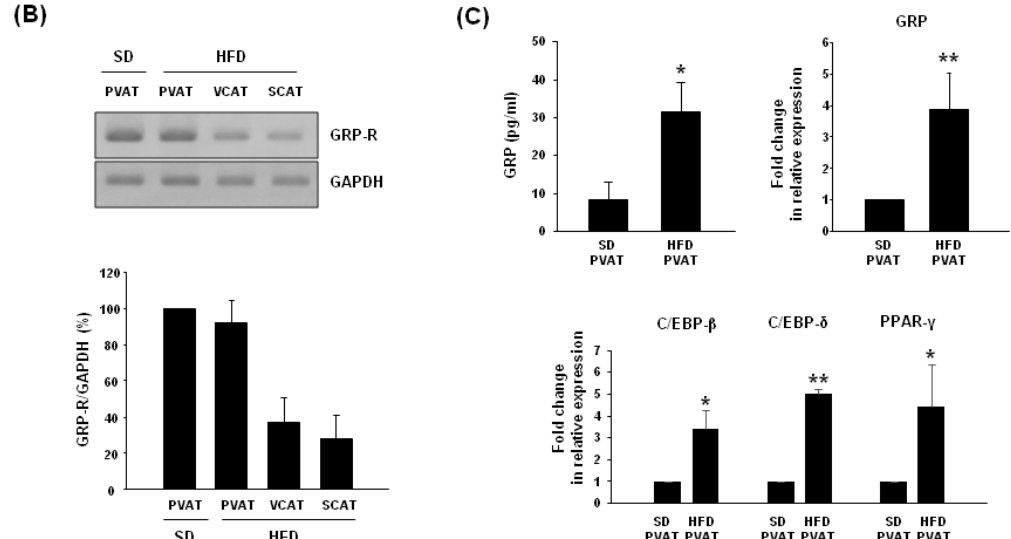
Figure 4. Expression of GRP-R and GRP in adipose tissues from obese rats. ( A ) The SD (standard diet) group was fed a standard diet, and the HFD (high-fat diet) group was fed a high-fat diet for 14 weeks. The body weight was measured once every two weeks. ( B ) All rats were sacrificed at week 14, and subcutaneous (SCAT), visceral (VCAT) or perivascular adipose tissues (PVAT) from the HFD group and perivascular adipose tissues from SD group were obtained. The total RNA was extracted from each adipose tissue and then analyzed by RT-PCR using primers specific for GRP-R. GAPDH served as an internal control (top). The graph shows the densitometric analysis of the relative GRP-R mRNA levels. The GRP-R expression from the PVAT of SD rats was set to 100% (bottom). ( C ) Conditioned medium from the PVAT of HFD-induced obese rats or from the PVAT of SD rats was prepared, respectively, and then, the secreted GRP protein in rat perivascular adipose tissue-conditioned medium was quantified by ELISA. The mRNA levels of GRP, C/EBP- β , C/EBP- δ , and PPAR- γ in PVAT of HFD-induced obese rats or in PVAT of SD rats were quantitatively analyzed by real-time PCR using specific primers for GRP, C/EBP- β , C/EBP- δ , or PPAR- γ . * p < 0.05, ** p < 0.01 was compared to the PVAT of SD rats.